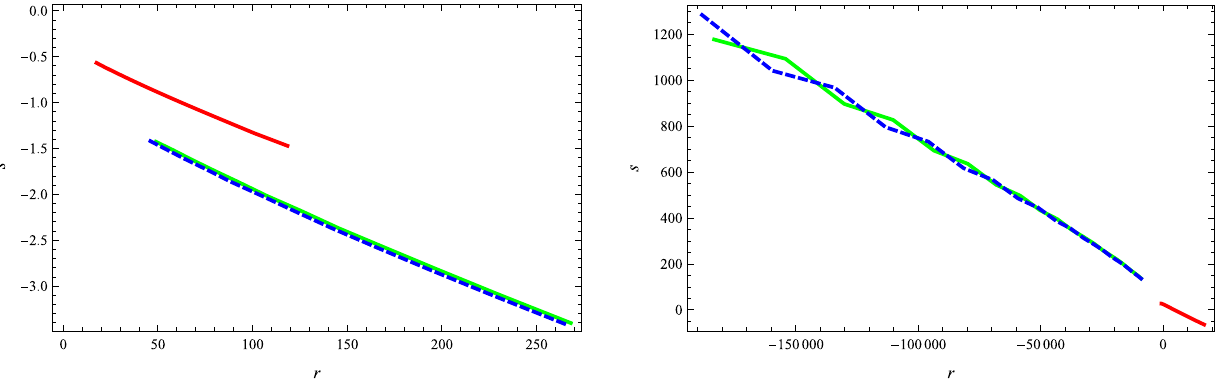
Fig. 14 Plots of unified phases r − s plane for u = 2 (left) and − 2 (right). Also, H 2 = 2 . 7 (red), H 2 = 2 . 75 (green) and H 2 = 2 . 8 (blue)